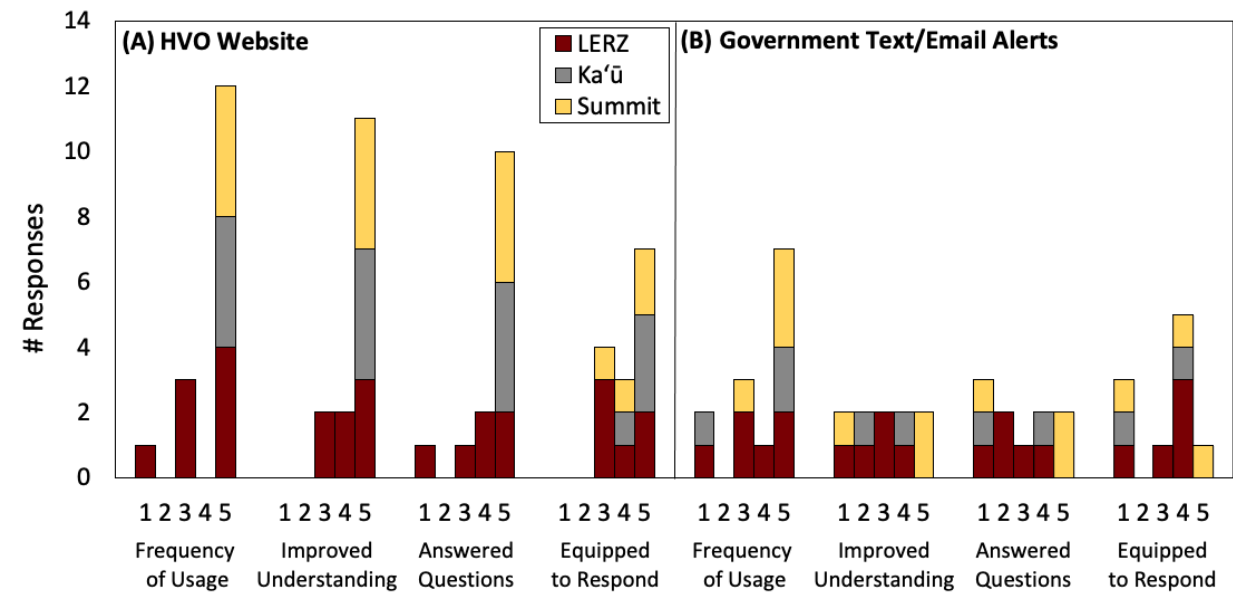
Figure 4: Participants’ responses regarding eruption information communicated from [A] the the U.S. Geological Survey Hawaiian Volcano Observatory (HVO), and [B] government text/email alerts. In each panel, the first cluster of graphs tallies how frequently participants reported using each channel, while the remaining three clusters plot participants’ Likert-type scores in response to the following questions: “During the eruption, to what extent did you feel that [each channel] ... (a) improved your